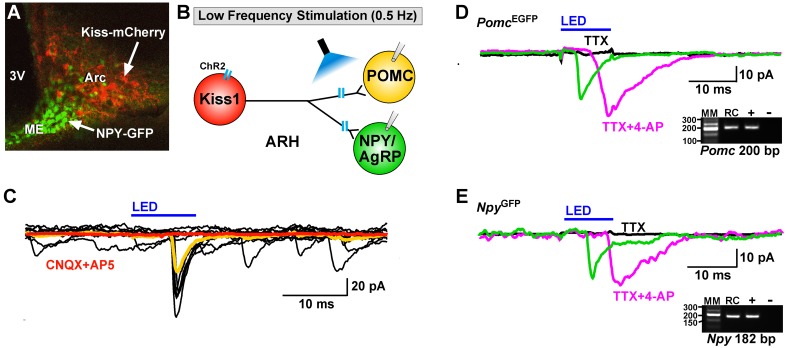
Optogenetic activation of Kiss1-ARH neurons directly excites POMC and NPY/AgRP neurons via glutamate release.(A) AAV1-DIO-ChR2:mCherry was bilaterally injected into ARH of Kiss1Cre: : NpyGFP mice or Kiss1Cre: : PomcEGFP (not shown). (B), schematic of experimental design; whole-cell, voltage-clamp (Vhold = −60 mV) recordings were made in POMCEGFP or NPYGFP neurons and a single pulse (intensity, 660 μW; 10 ms duration) of blue light (470 nm) was delivered to the ARH. (C), a fast inward current was recorded in both POMC and NPY neurons (yellow trace is average) that was antagonized by CNQX (10 µM) and AP5 (50 µM) (red trace). (D,E), the optogenetic (glutamate) response (green trace) was abrogated in the presence of TTX (1 µM, black trace) but rescued with the addition of the K+ channel blocker 4-AP (100 µM, magenta trace) in both POMC (D) and NPY (E) neurons, n = 3 and 2, respectively. Insets show the scRT-PCR post hoc identification of representative recorded Pomc and Npy neurons. RC, recorded cell; +, positive control (with reverse transcriptase); -, negative control (without reverse transcriptase); MM, molecular marker.